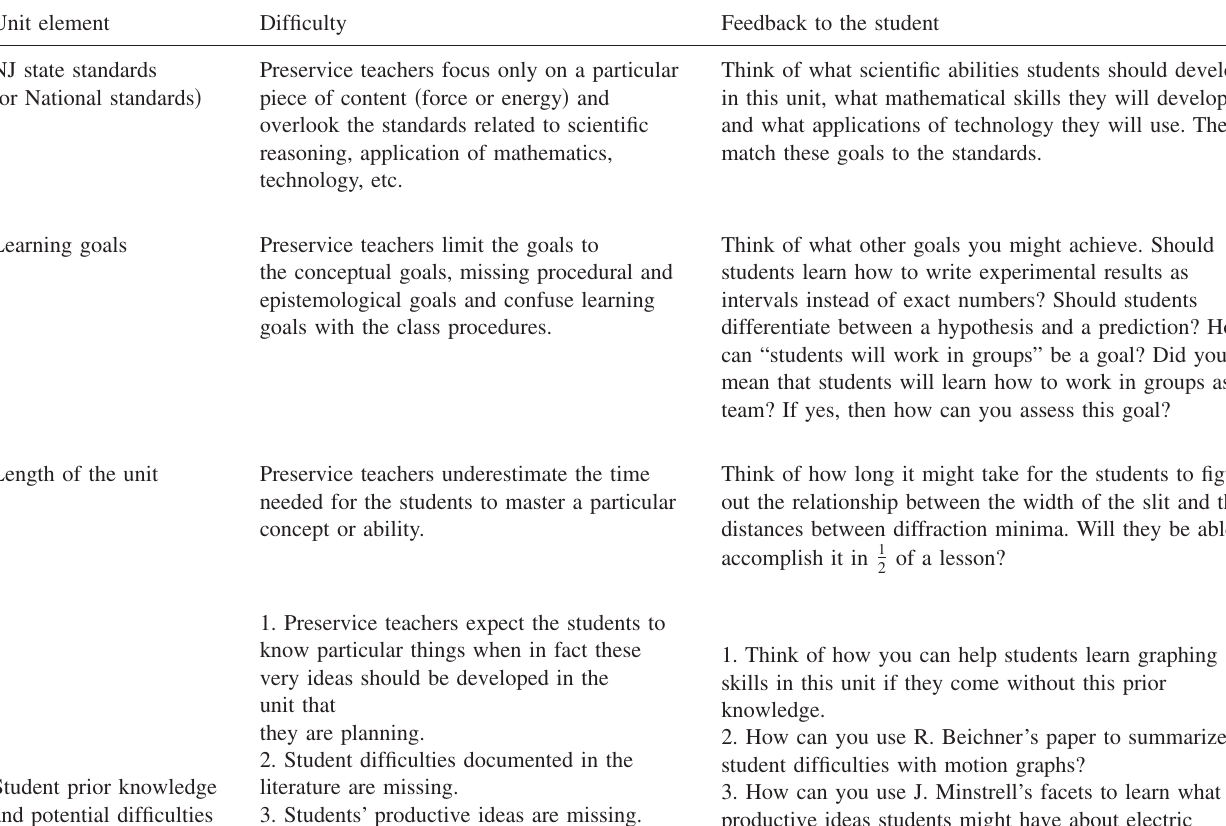
TABLE V. Preservice teachers’ difficulties with a unit